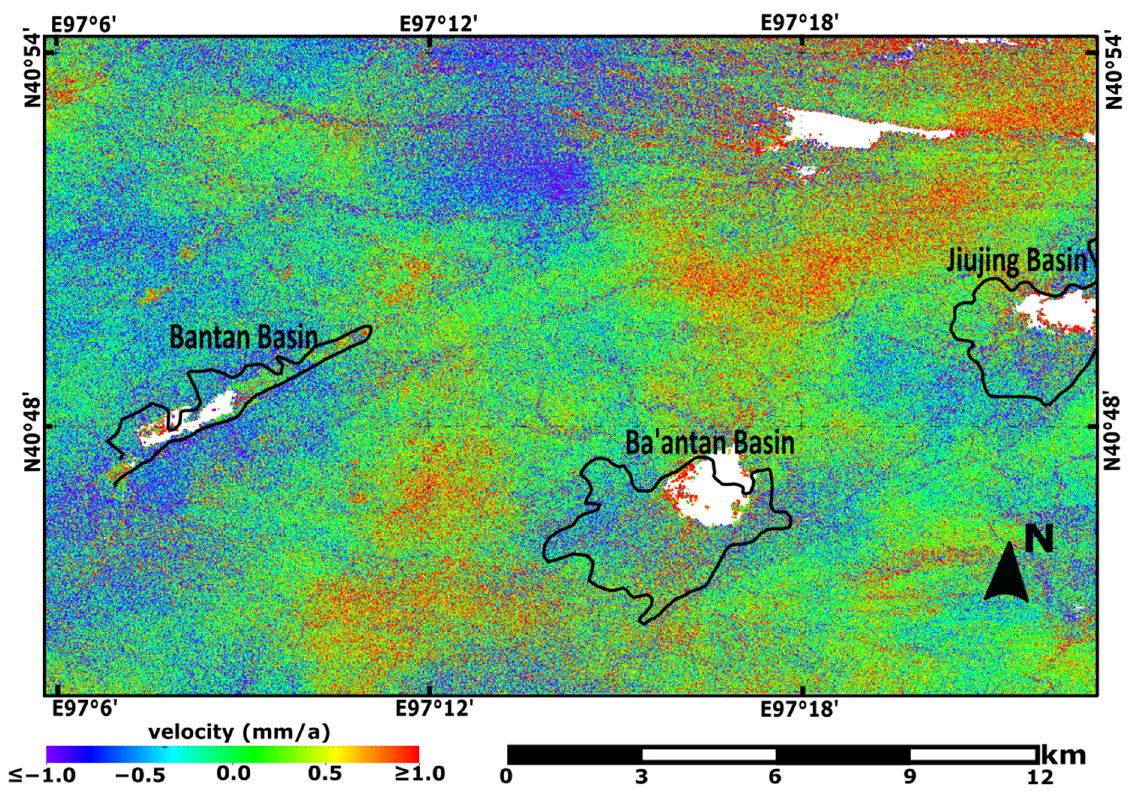
Figure 15. The locations of Bantan Basin, Ba’antan Basin, and Jiujing Basin within vertical deformation (D U ) patterns (black outlines indicate Quaternary sediments).